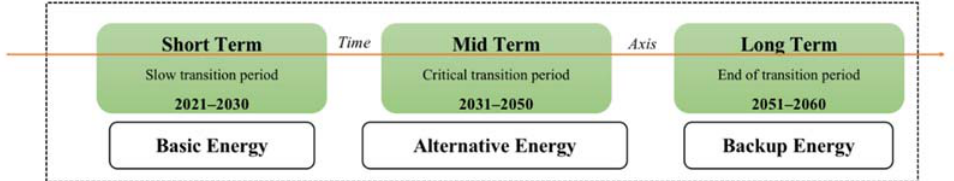
Figure 3. Phased coal reduction path.